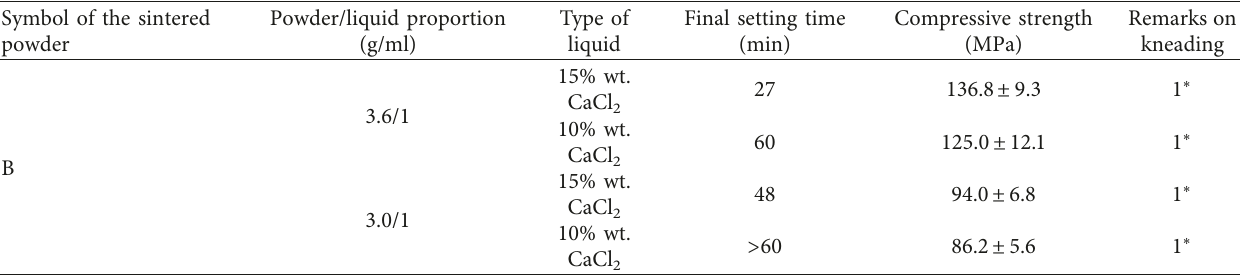
Figure 1: XRD patterns of sintered powders A, B, and C along with the identification of marked phases. Producing the MTA-type cement and its characteristics. Table 4: Impact of powder/liquid proportions and CaCl 2 concentration on the setting time, compressive strength, and kneading capacity of the cements, when compared with the reference